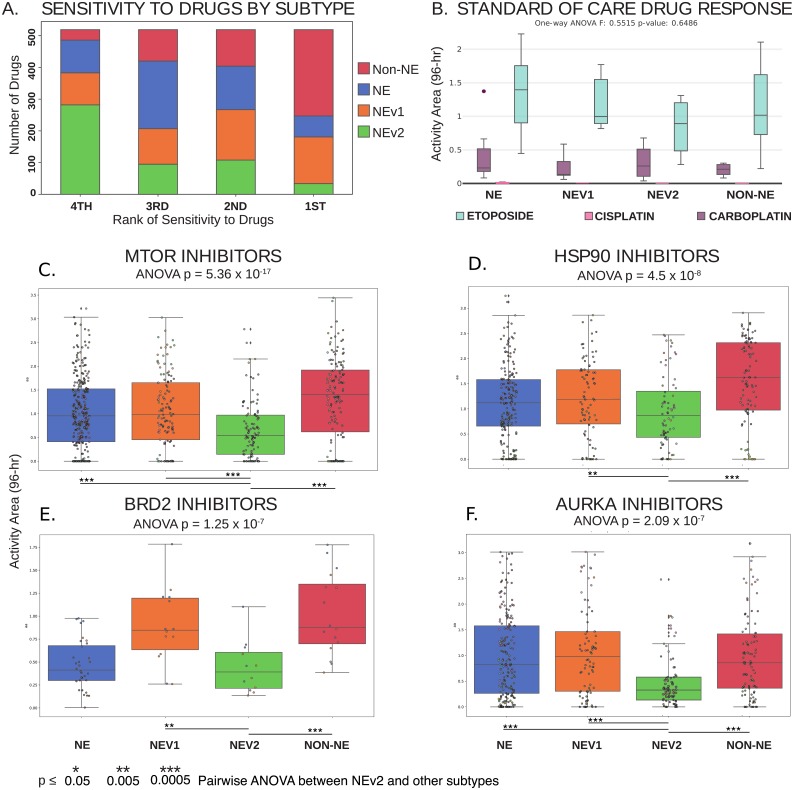
Differential response of SCLC subtypes to a wide variety of oncology drugs and investigational agents.A. Ranked sensitivity of subtypes across 526 compounds. NEv2 is least sensitive for over half of the drugs tested. B. No significant differences can be seen in response to etoposide and platinum-based agents cisplatin and carboplatin, the standard of care for SCLC. C-F. Significantly differential response by ANOVA, p < 0.05, shown in drugs that target C. mTOR, D. HSP90, E. BRD2, and F. AURKA. NEv2 is significantly more resistant to all of these drugs.